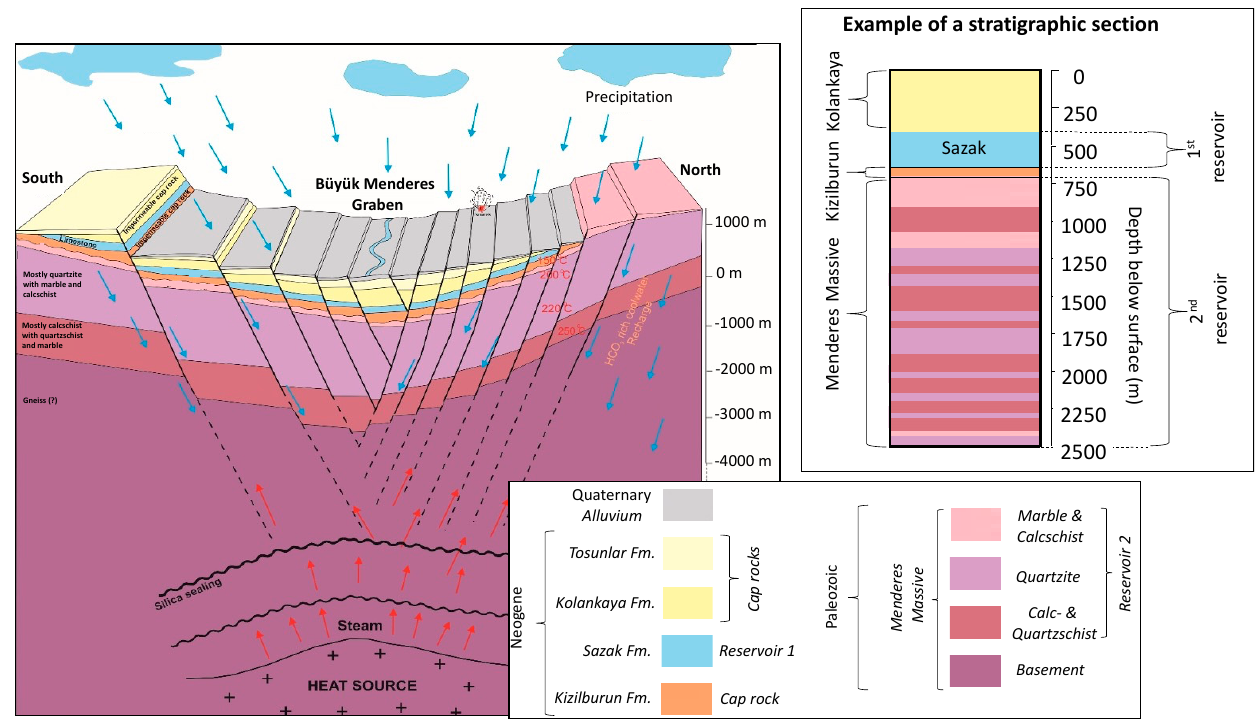
Figure 1. Left: Kızıldere geothermal field conceptual model using the most recent reservoir classification (revised after [33]). Right: Example of a stratigraphic section, revealing the actual formation sequence represented by the three different lithologies that make up the second reservoir.